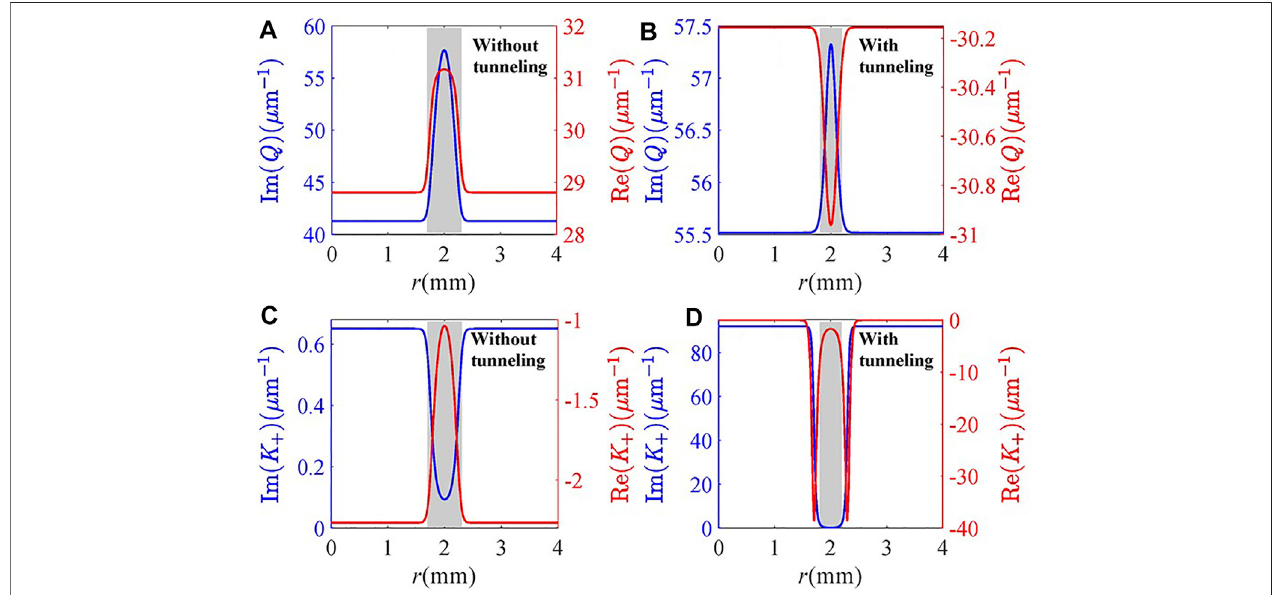
FIGURE3| Realandimaginarypartsof (A,B) Q and (C,D) K + versusradius r fordifferentvaluesof α , β ,and δ : (A,C) α = β =0, δ =0 meV; (B,D) α = − 0.11, β =0.98, δ = 5.1 meV. Other parameters are the same as in Figure 2 .